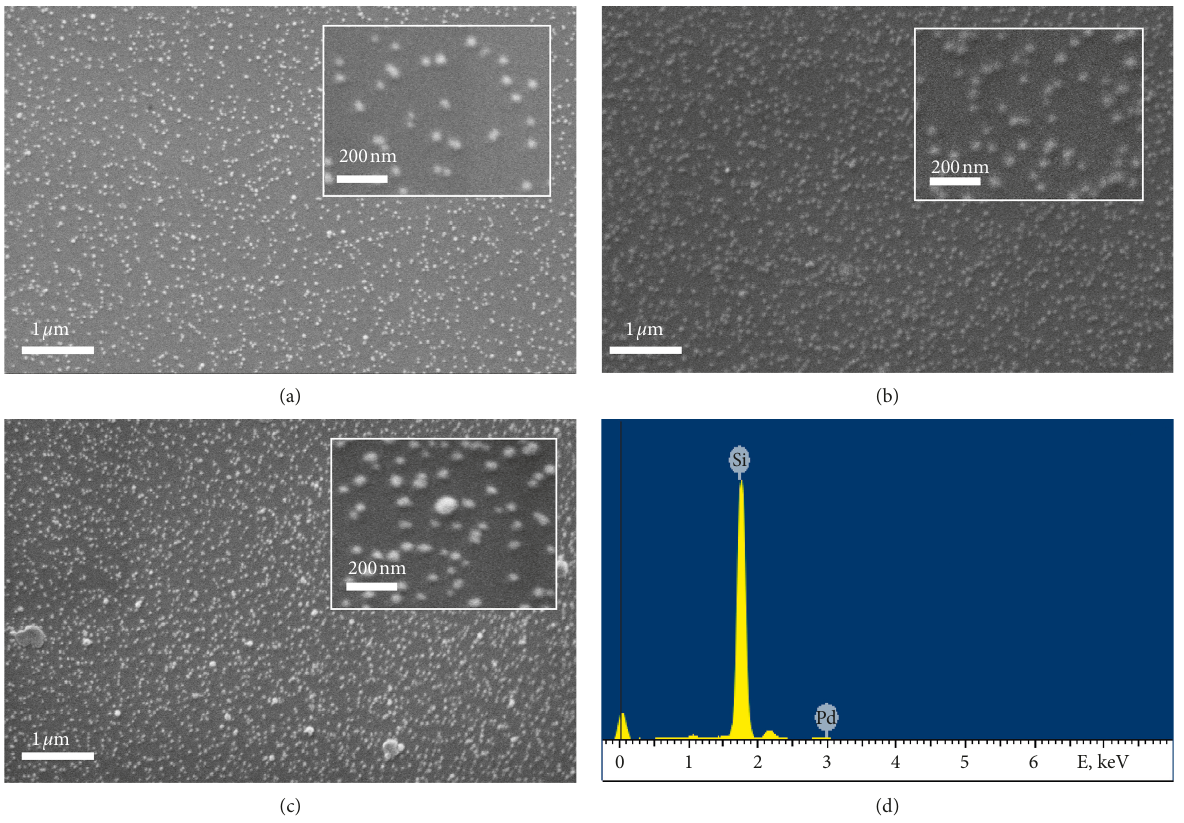
3 ) 2 +50mM Bu 4 NClO 4 mixed